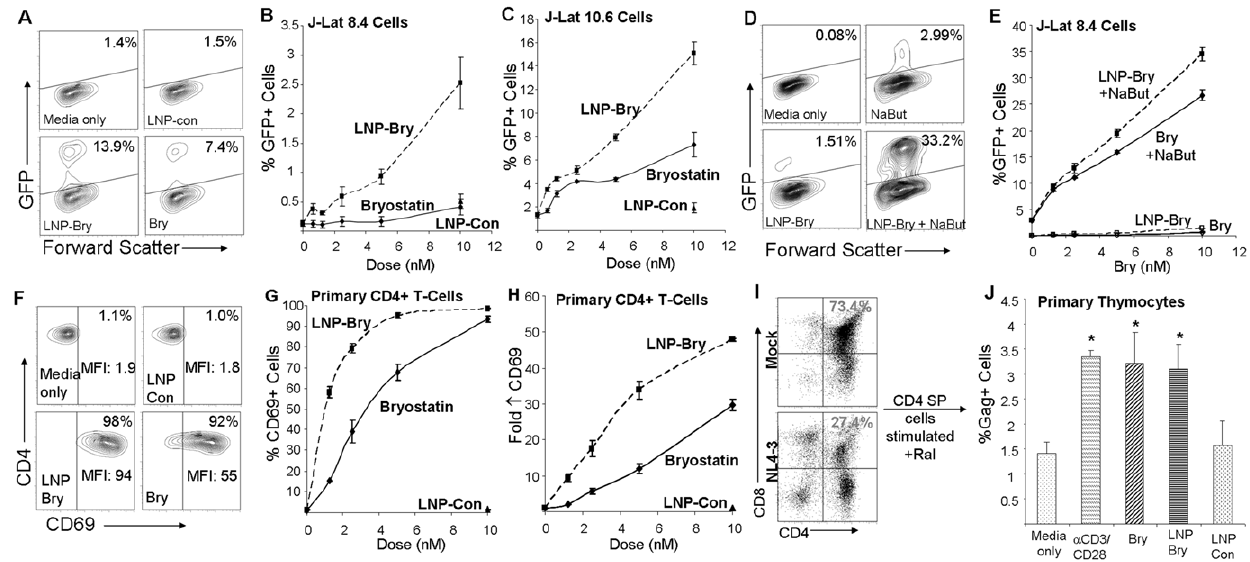
Figure 2. Effects of LNP-Bry on latent virus expression and induction of CD69. (A) Representative flow cytometry plots of GFP expressing J- Lat 10.6 cells incubated with 10 nM bryostatin-2 or brostain-2 loaded LNP (LNP-Bry). (B) Percentage GFP + cells was measured after incubation of LNP- Bry or bryostatin-2 with J-Lat 8.4 cells for 16 hr. (C) Percentage GFP + cells was measured after incubation of LNP-Bry or bryostatin with J-Lat 10.6 cell lines for 16 hr. (D) Representative flow cytometry plots displaying the synergistic effect of 2 mM sodium butyrate (NaBut) in conjunction with LNP-Bry in J-Lat 8.4 cells. (E) J-Lat 8.4 cells were incubated with a fixed dose of NaBut (2 mM) and increasing dose of bryostatin-2 or LNP-Bry. (F) Representative flow cytometry plots displaying CD69 induction in primary resting CD4 + cells after incubation with LNP-Bry or bryostatin-2 for 16 hr. (G) Percentage CD69 + cells as detected by flow cytometric analysis. (H) Fold increase in CD69 mean fluorescence intensity was measured after incubation with increasing amounts of LNP-Bry or bryostatin-2 in primary CD4 + cells. (I) Flow cytometry plots displaying the CD4 + /CD8 + cell profiles from mock or NL4-3 infected SCID-hu (Thy/Liv) implants. (J) In the presence of 1 m M raltegravir, CD4 single-positive thymocytes were stimulated ex- vivo with anti-CD3/CD28 beads, 10 nM bryostatin-2 or 10 nM LNP-Bry for 48 hr and assayed for intracellular Gag protein by flow cytometry. Error bars indicate the standard deviation of triplicate data points and are representative of at least 2 experiments. * p , 0.01 as compared with media only (infected non-stimulated cultures) or LNP-con (non-drug loaded nanoparticles) in a paired t-test.